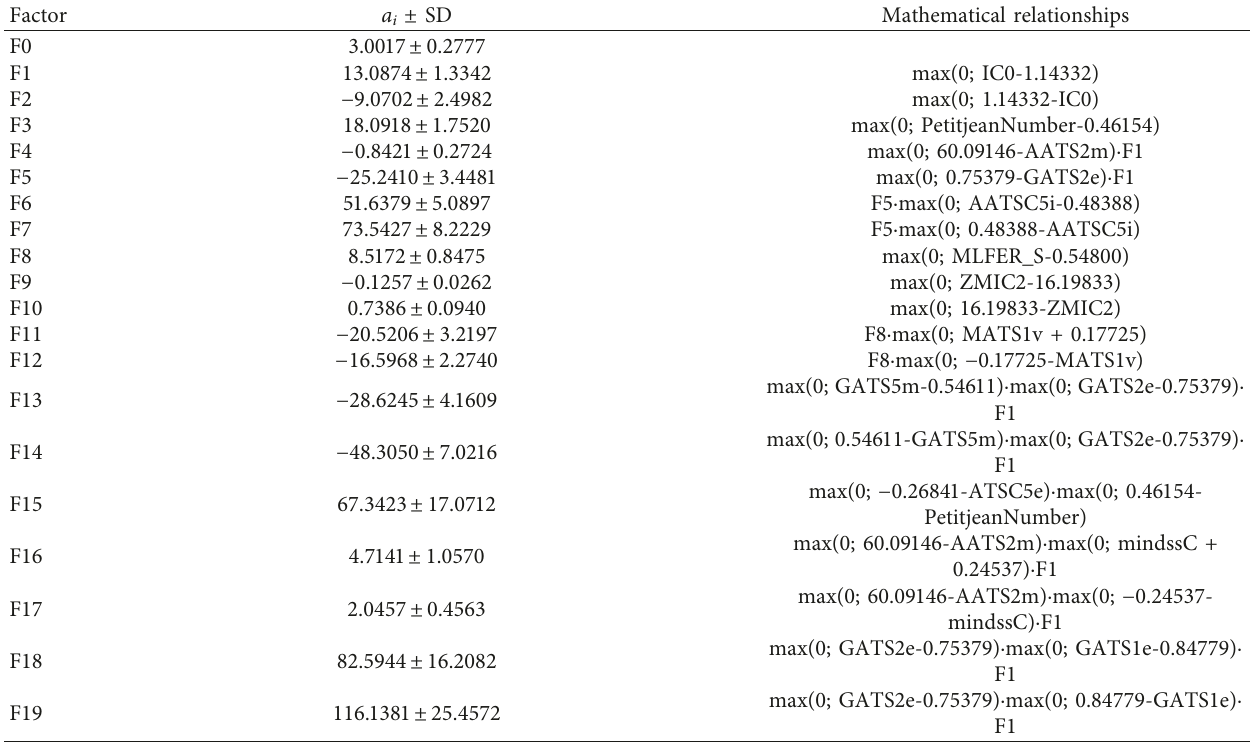
Model statistics: fitting criteria: N � 130, R 2 � 0.954, R 2 adj � 0.945, F � 122.2, and LOF � 3.533; internal validation criteria: LMO (30%), Q 2 loo � 0.935, RMSE � 1.771, and MAE � 1.247.